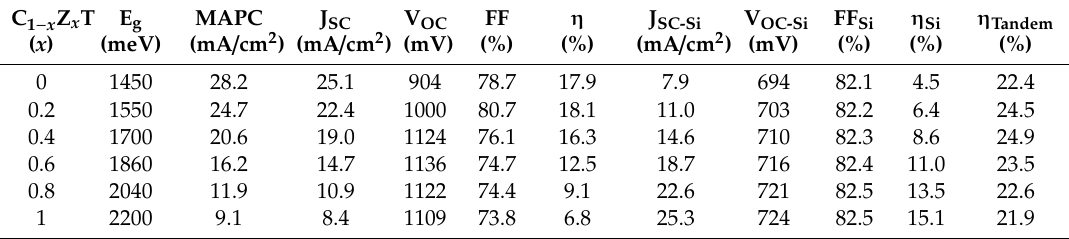
Table 3. Electrical and optical device simulation data for a normal top cell structure with 50 nm Mg 0.23 Zn 0.77 O as ETL, and the corresponding IBC Si rear and tandem cell structures as a function of the Zn concentration in C 1 − x Z x T. Series and shunt resistances are used as 2 and 2000 Ω / cm 2 . The minority carrier lifetime is assumed to be 5 ns in top cell absorbers and surface recombination velocity at the ETL / top cell absorber interface is taken as 500 cm /